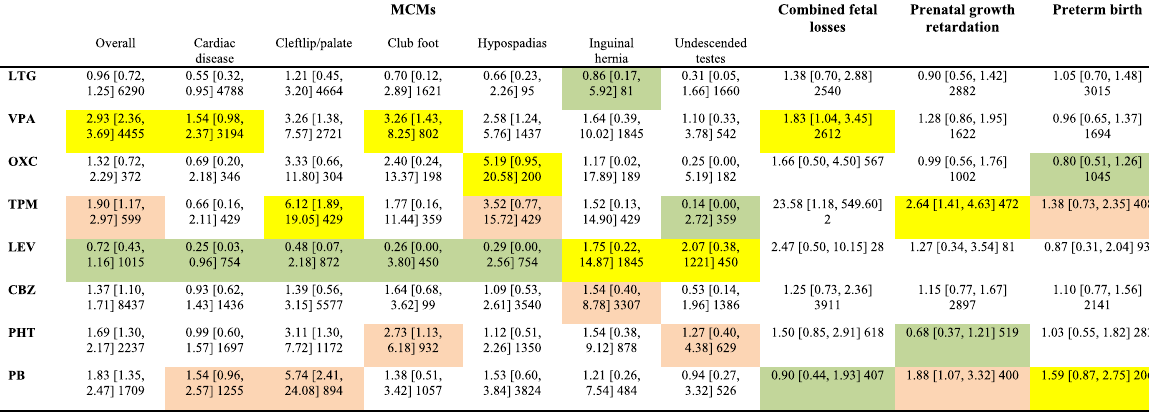
Each cell consists of three parts, odds ratio, [95% credible intervals], and number of cases; yellow cells mean the highest OR, pink cells mean the second higher OR, green cells mean the lowest